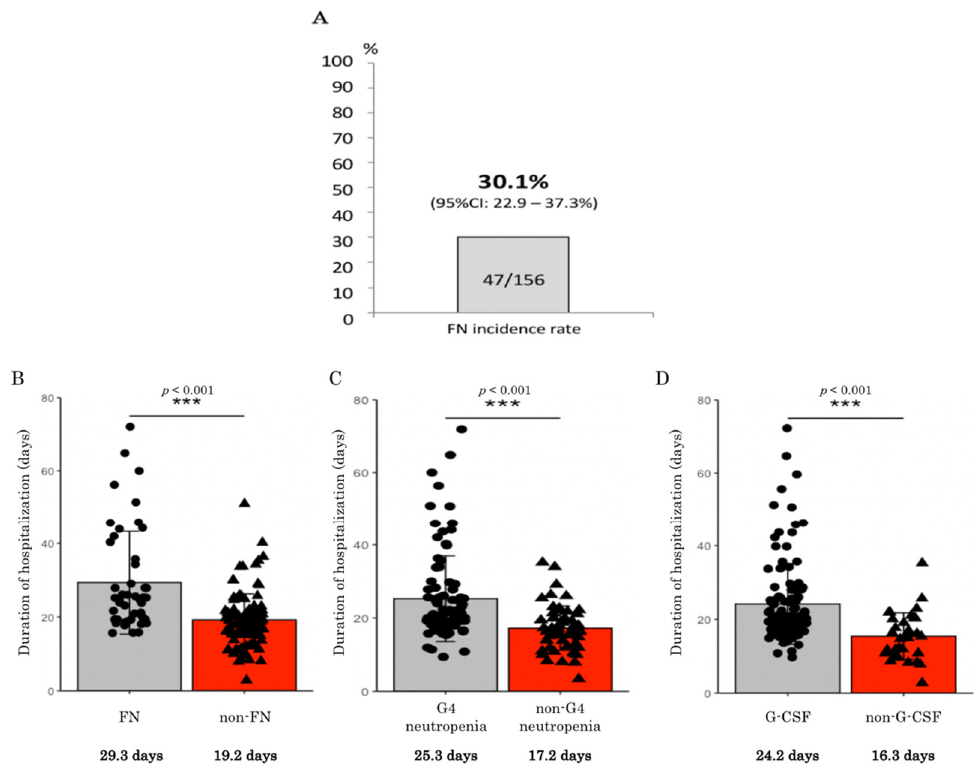
Figure 1. ( A ) Febrile neutropenia (FN) incidence rate in 156 patients who received single-agent amrubicin chemotherapy. ( B ) Duration of hospitalization period among patients that received amrubicin chemotherapy with or without febrile neutropenia (FN). ( C ) Duration of hospitalization period among patients that received amrubicin chemotherapy with or without grade 4 (G4) neutropenia. ( D ) Duration of hospitalization period among patients that received amrubicin chemotherapy with or without G-CSF. ***: statistically significant difference; G-CSF: granulocyte colony-stimulating factor; CI: confidence interval Table 2. Hematological toxicities ( N = 156).